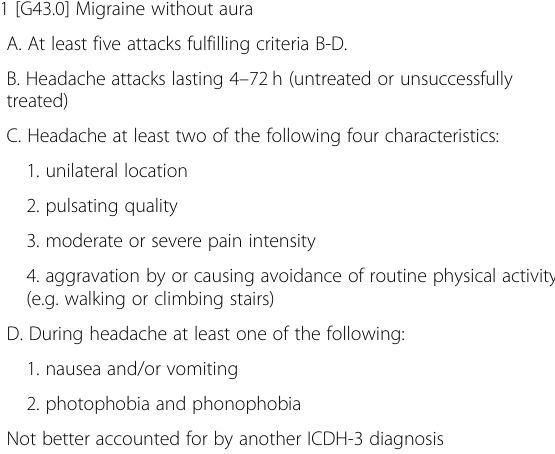
Table 3 Classification of migraine without aura and typical aura with migraine headache [2]